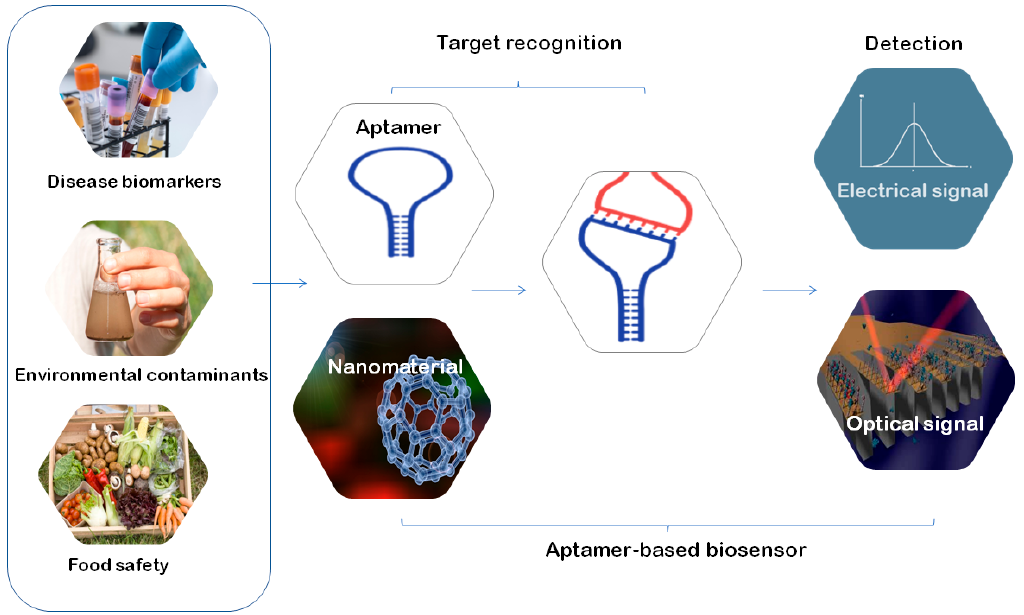
Figure 3. Aptamers used in biosensors. Aptamer-based biosensors are used to detect disease biomarkers, monitor environmental contaminants, or to ensure food safety. Aptamers can be further enhanced by different nanomaterials or biomaterials. The signal of detection in the most of the recently developed aptamer-based biosensors is based on electric or optic/fluorescent signal.